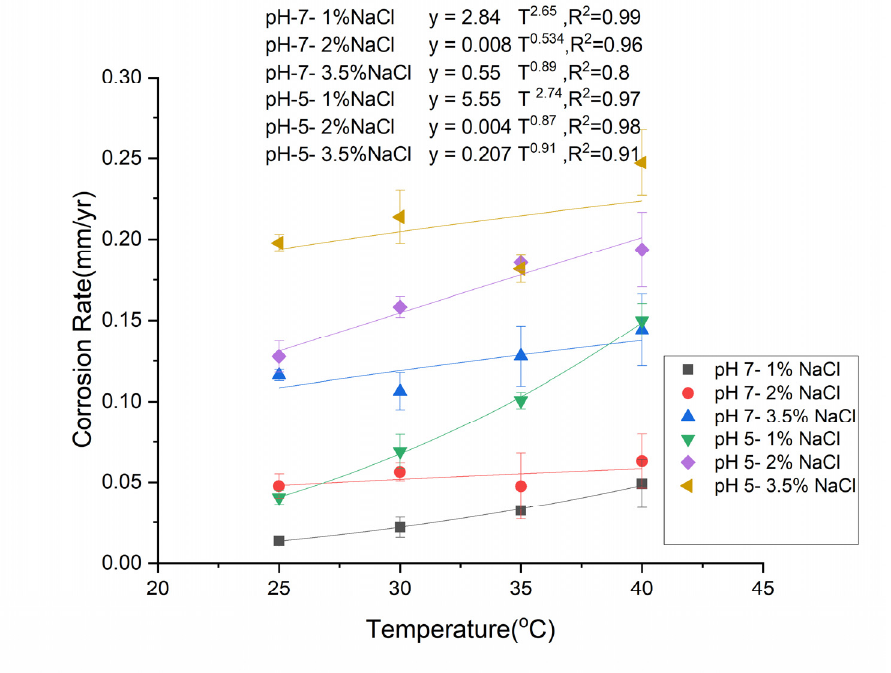
Figure 13. Corrosion rates at different temperatures for flow insensitive regions are fitted using Power-law.